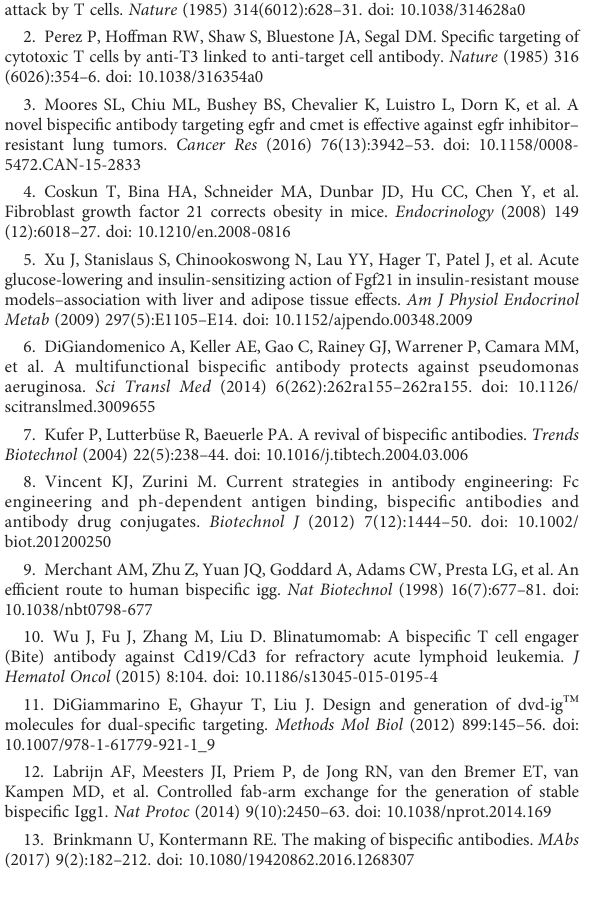
SUPPLEMENTARY TABLE 1 Fc mutations involved in bispeci fi c platforms. SUPPLEMENTARY TABLE 2 Fab mutations involved in bispeci fi c platforms. SUPPLEMENTARY TABLE 3 Interacting pairs of residues across the C H 1-C L interface. SUPPLEMENTARY TABLE 4 SIN scores, BSA and distance from pseudo two-fold axis of C H 1-C L interface residues. SUPPLEMENTARY TABLE 5 Rational structure-based designs of constant regions. Expression levels of matched and mismatched antibodies relative to their unmodi fi ed versions were computed in percentage form. ‘ - ’ : expression not quanti fi ed due to missing heavy or light chain. ND: not determined. Columns 3 & 6 represent % expression levels of correctly paired species whereas columns 8 & 9 represent % expression levels of mispaired species (also refer Figure S2). SUPPLEMENTARY TABLE 6 Rational structure-based designs of both the C H 1 - C L mutations – relative expression of cognate heavy-light paired and mispaired